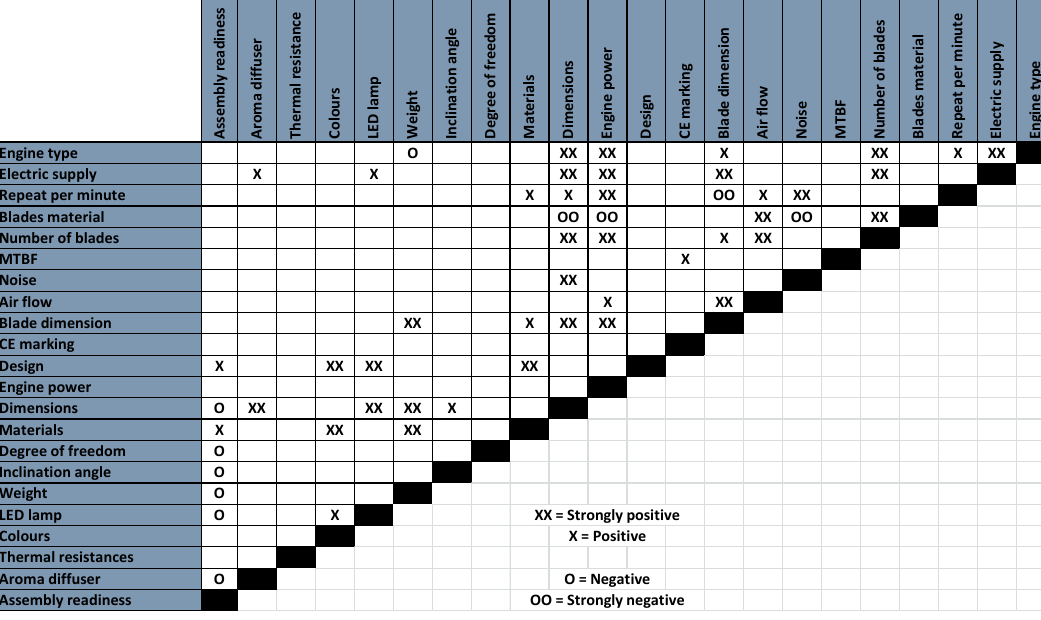
Figure 8. Interrelationship matrix.